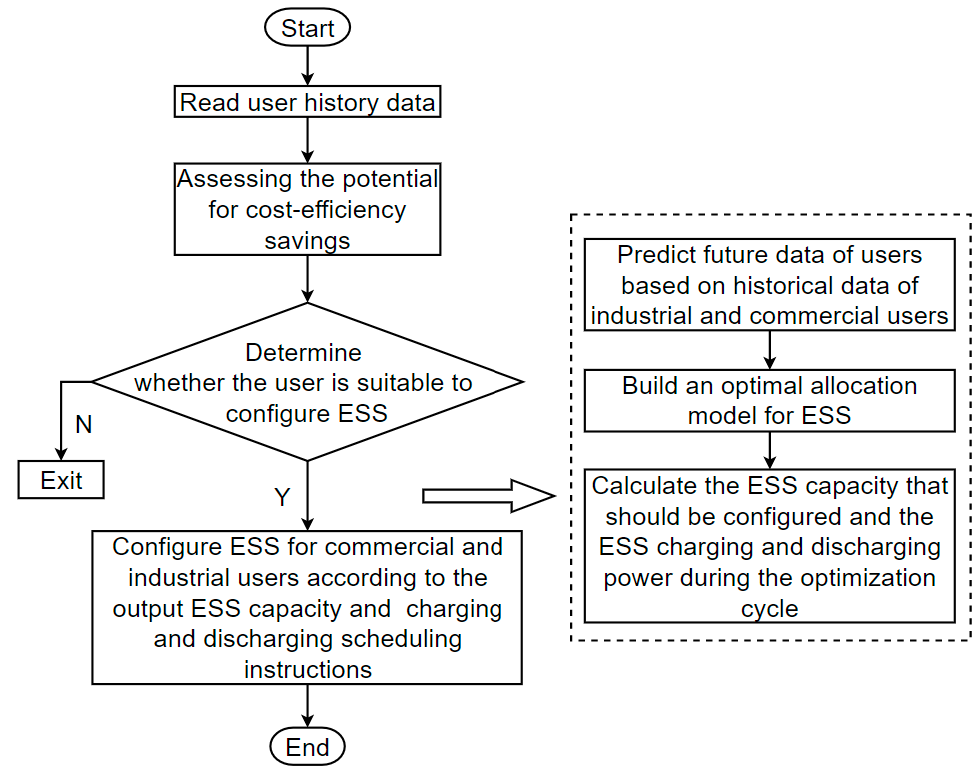
Figure 2. Smart power sales